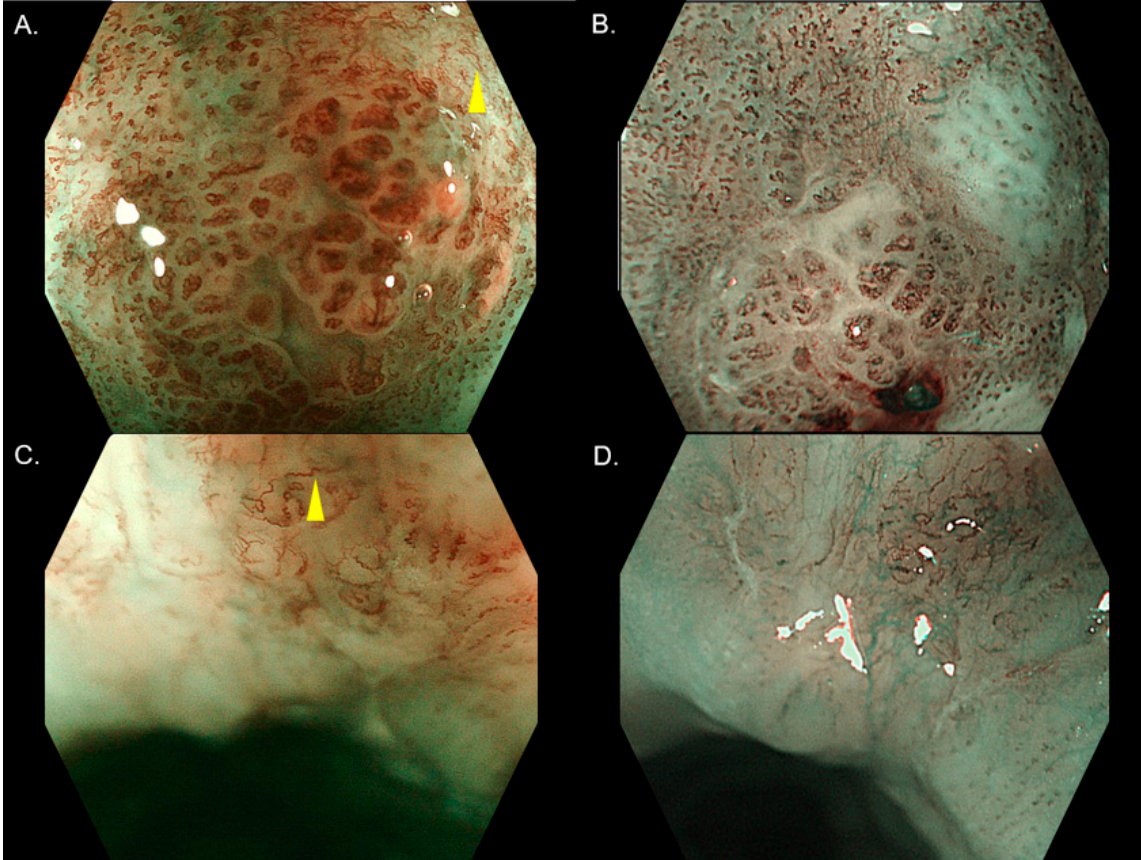
Figure 3. Cases with different diagnoses of the invasion depth between ME-BLI and ME-NBI. ( A ) ME-BLI image in case 1. ( B ) ME-NBI image in case 1. ( C ) ME-BLI image in case 2. ( D ) ME-NBI image in case 2. In both cases, two investigators diagnosed them as having B2 vessels (yellow arrows) in ME-BLI, whereas only B1 vessels were found by them in ME-NBI. ME-BLI, magnifying endoscopy with blue light imaging; ME-NBI, magnifying endoscopy with narrow band